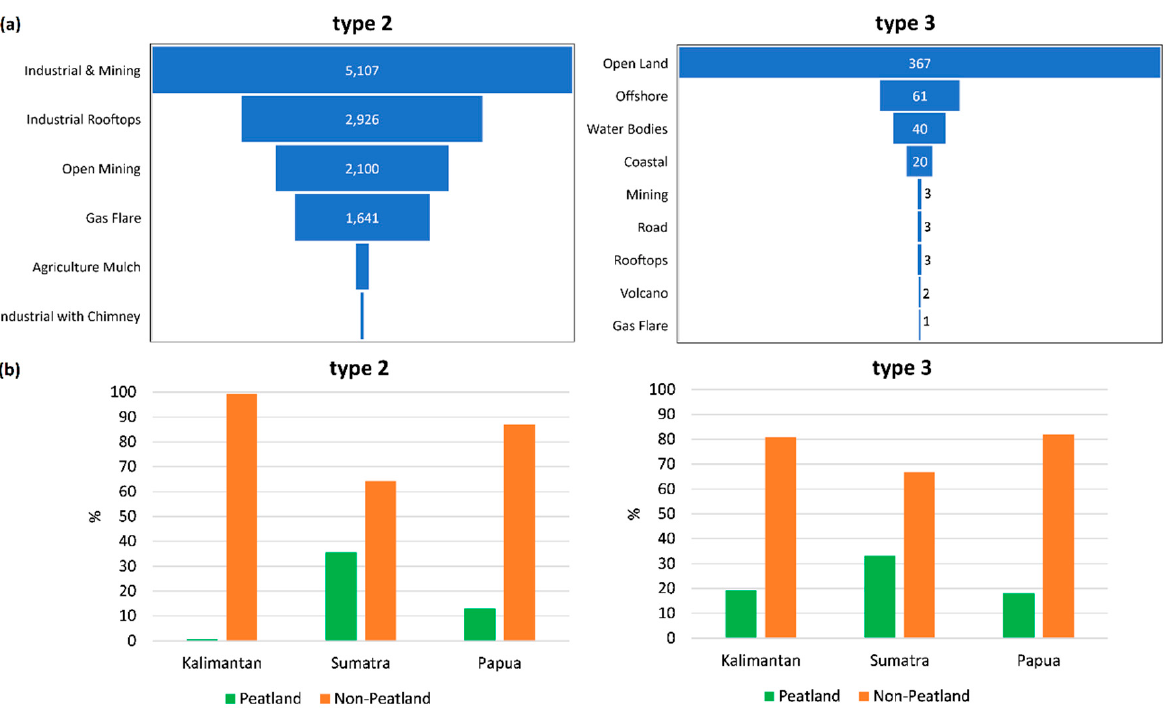
Figure 3. ( a ) The allocation of dominated objects in thermal anomaly type-2 and thermal anomaly of type-3 over Indonesian region were analyzed using high-resolution images; ( b ) the percentage of number of type-2 and type-3 data on peatland and non-peatland in Kalimantan, Sumatra, and Papua. data were approximately 99% (Kalimantan), 64% (Sumatra), and 87% (Papua) in